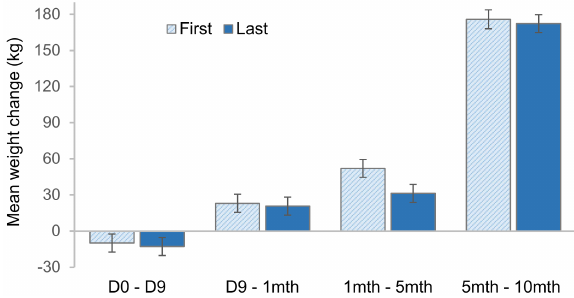
Figure 4. Mean weight change ± 95% CI’s for the First and Last Movement Groups during each time period in the experiment. Heifer weights were recorded at the beginning and end of yard weaning (D0 and D9) then 1, 5 and 10 months post-weaning. Heifers were retrospectively grouped as First or Last depending on whether they were consistently one of the first or last 20 animals to move through the funnel during days 2–6 of acclimation testing. Data were analysed using a multilevel linear model, indicating a significant interaction between Movement Group and Time period ( p = 0.035). Least-squares means were then used to determine the significance of differences between Movement Groups for each time